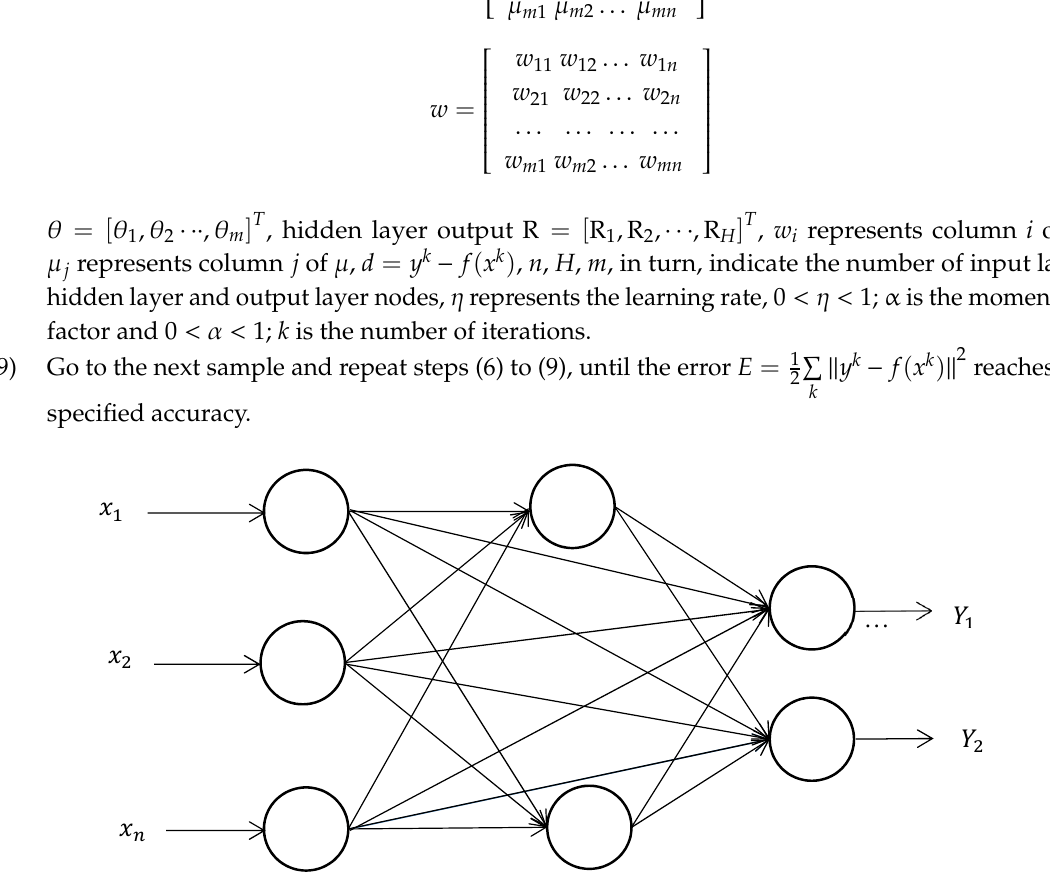
Figure 2. Improved radial basis function (RBF) neural network structure.